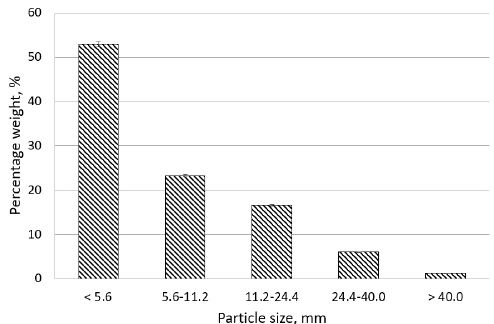
Figure 2. Fractional composition of BA (%).